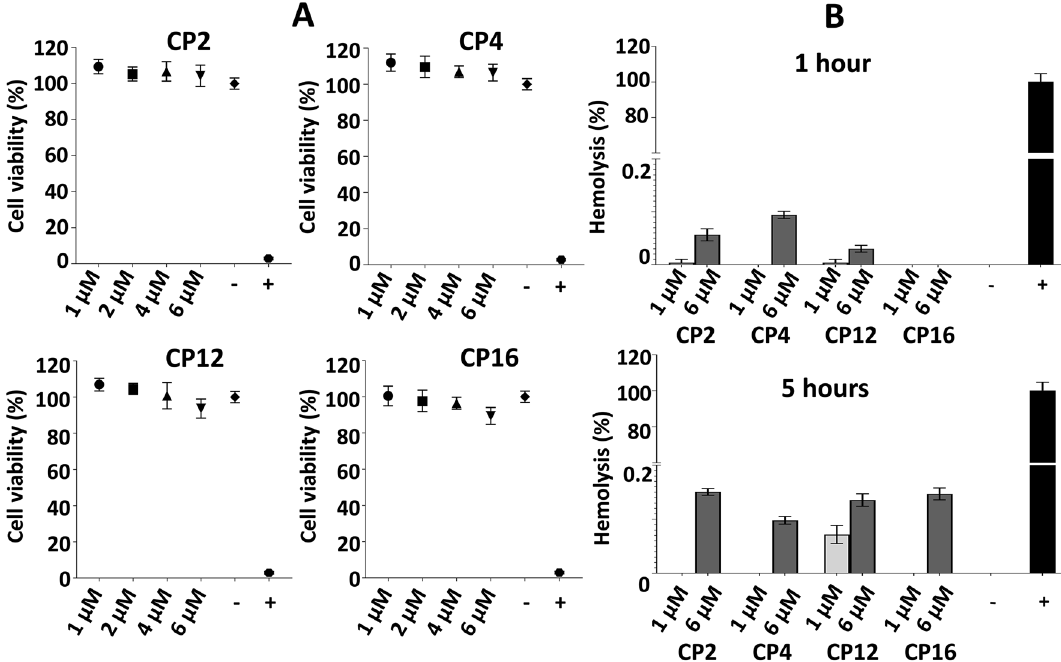
Figure 6. Cytotoxic and hemolytic activity of peptides. ( A ) Cytotoxicity of DIII blocking peptides assessed by XTT test after 24 h of incubation at different concentrations. A statistically significant difference (P < 0.01, two-tailed P-value) was calculated by unpaired t-test with Welch´s correction compared to the negative control (untreated cells). None of the peptides showed significant cytotoxicity. Statistics was performed with GraphPad Prism v8.4.3. “-” – negative control (untreated hBMECs); “+” – positive control (cells treated with 0.1% Triton X-100); CP – 7-mer cyclic peptide. ( B ) Assessment of hemolytic activity of peptides. Suspension of sheep erythrocytes was incubated with peptides at two different concentrations. No hemolytic effect (no release of hemoglobin) of peptides was observed. “-” – negative control (untreated sheep erythrocytes); “+” – positive control (sheep erythrocytes treated with 0.1% Triton X-100); CP – 7-mer cyclic